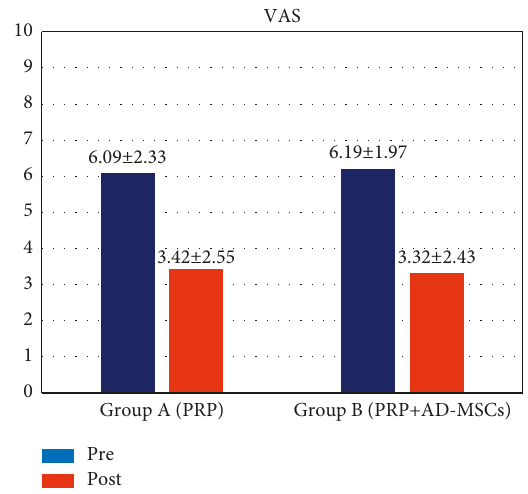
Figure 4: VAS (visual analogue scale) score: pretreatment and at 12-months follow-up.